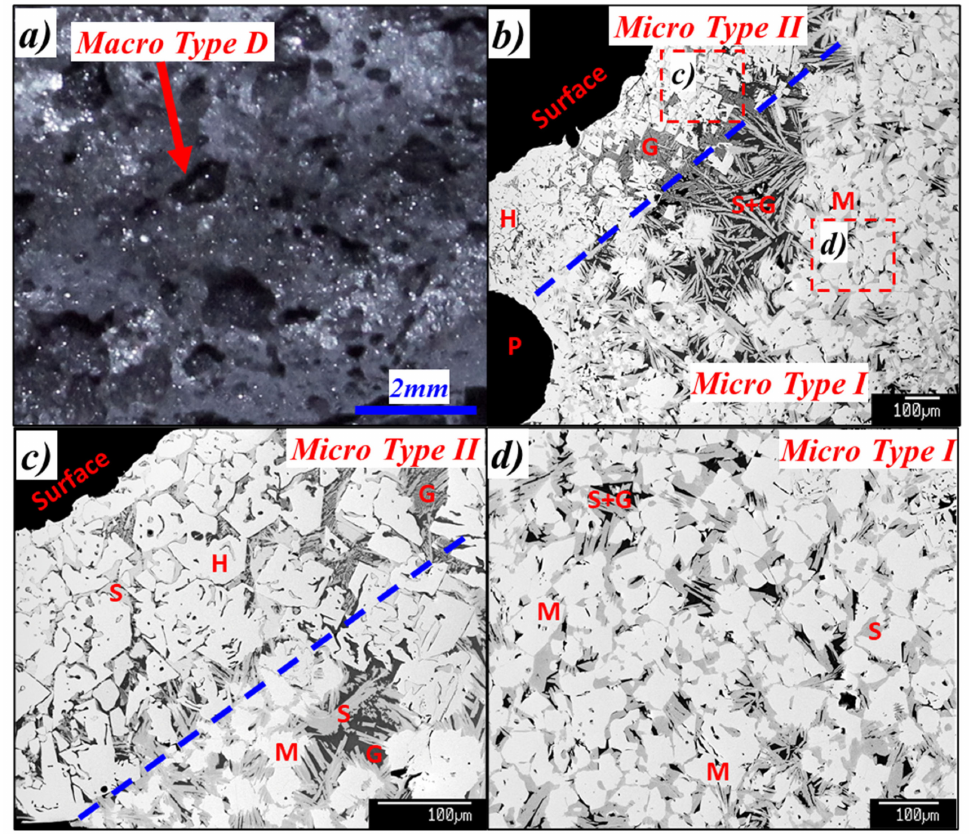
Figure 7. ( a ) Details of macro-features of type D (shiny/fractured surface large pores) taken by digital camera; ( b ) overview of interface between two microstructures in Macro-Type D; ( c , d ) details from different locations of ( b ), G = Glass; H = Hematite; M = Magnetite; S = SFCA solid solution; D = Dicalcium silicate (C 2 S); P =